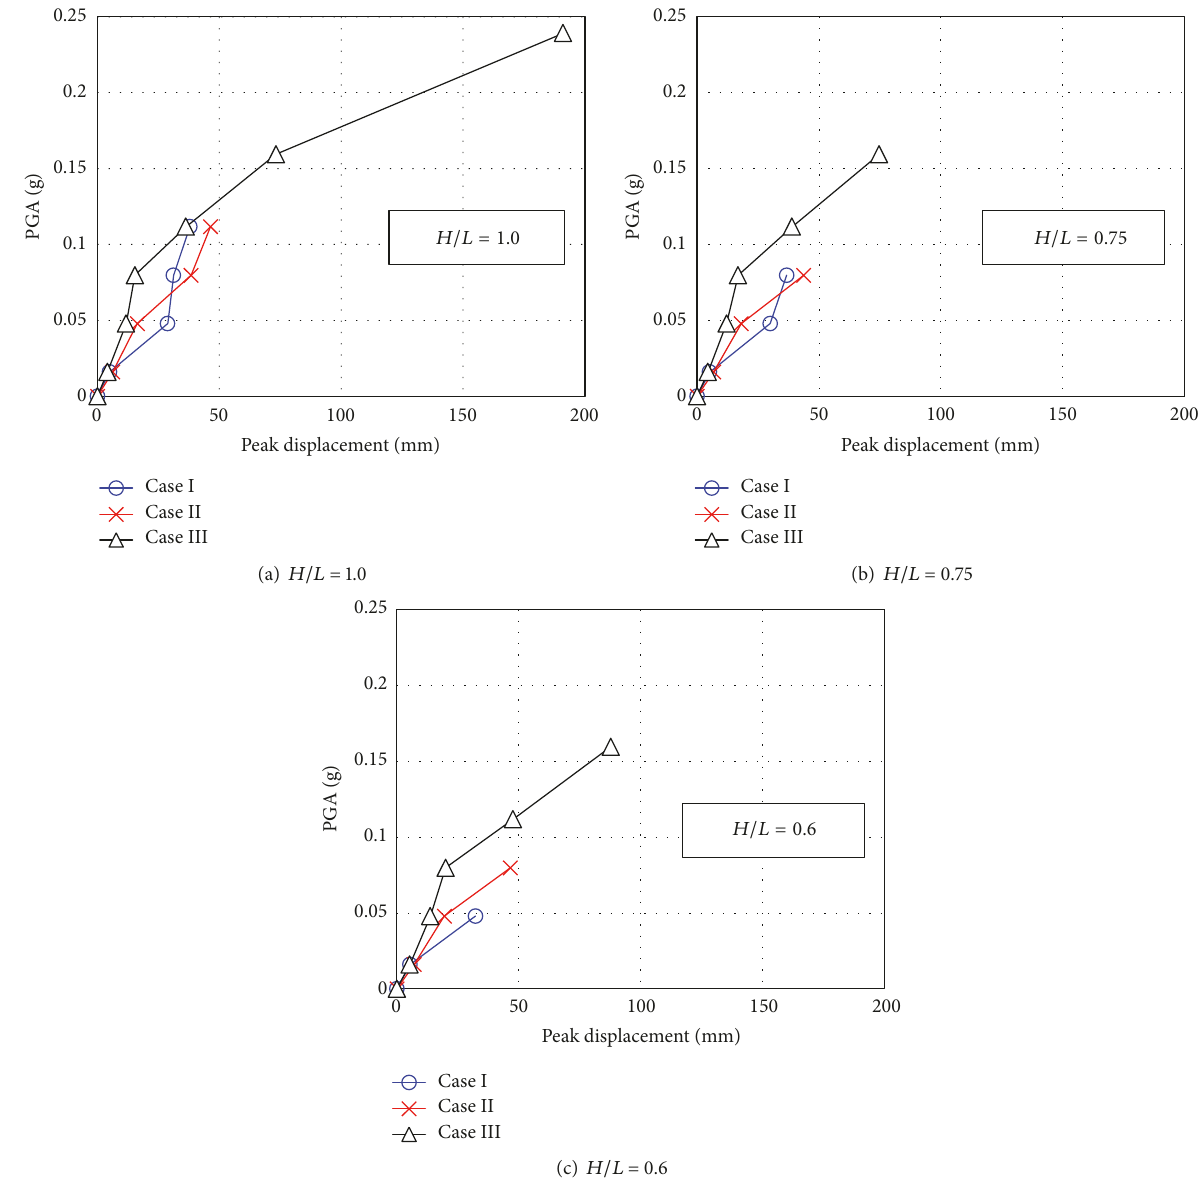
Figure 10: IDA results of the infill walls under El-Centro ground